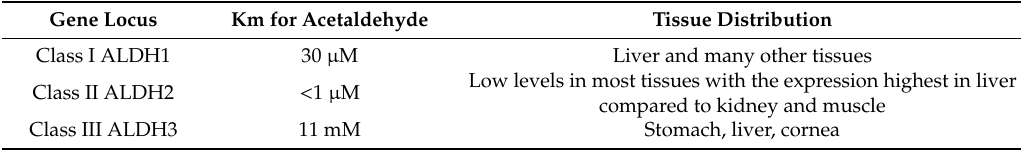
Table2. Kmforacetaldehydeandtissuedistributionofhumanaldehydedehydrogenase(ALDH)[23,29]. Gene Locus Km for Acetaldehyde Tissue